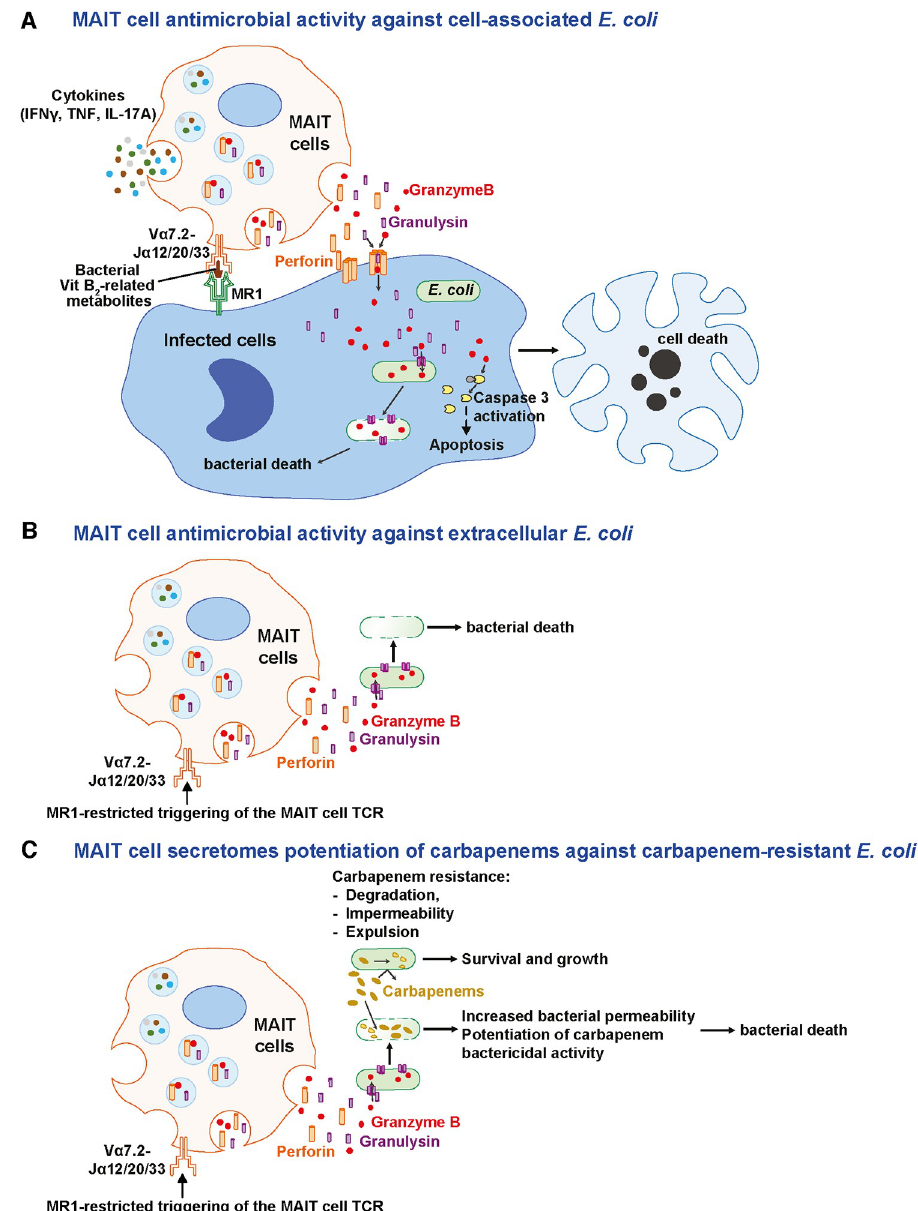
Fig 6. A model of MAIT cell antimicrobial activity against cell-associated (A) and extracellular (B) drug-sensitive E . coli and CREC, and (C) MAIT cell secretome potentiation of carbapenem killing activity against carbapenem- resistant E . coli strains. CREC, carbapenem-resistant E . coli ; IFN γ , interferon- γ ; IL-17A; interleukin-17A MAIT, Mucosa-associated invariant T; MR1, MHC-Ib-related protein; TCR, T cell receptor; TNF, tumor necrosis factor.